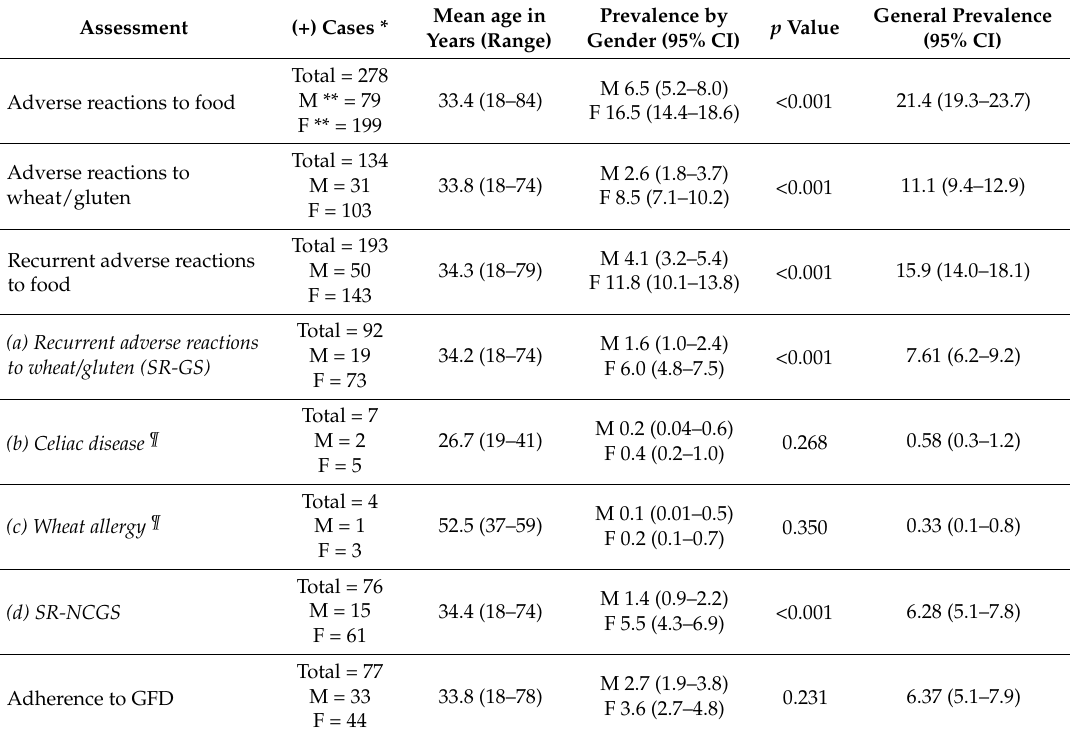
Table 2. Self-reported prevalence rates estimations.